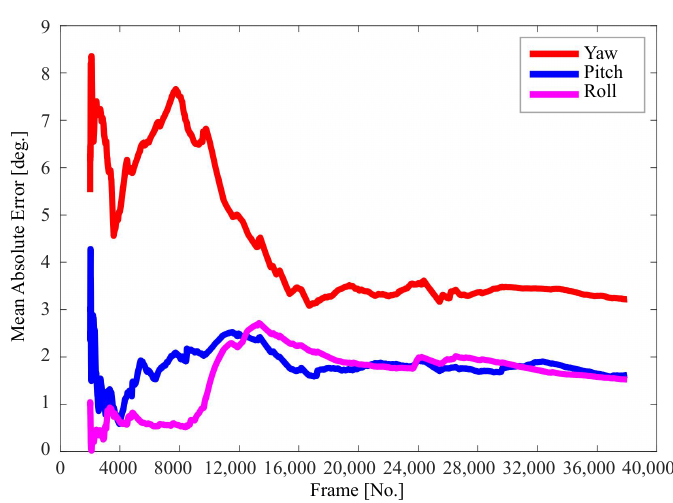
Figure 10. Mean absolute error curve in the yaw, pitch and roll directions.